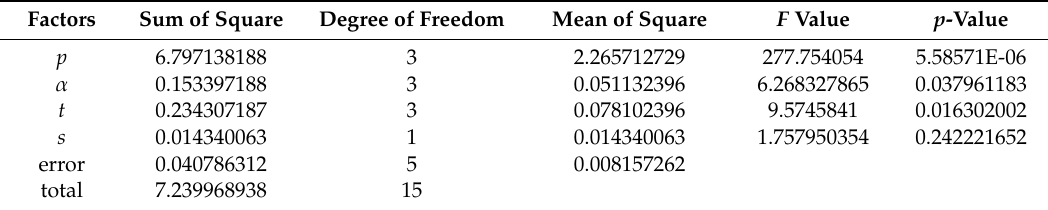
Table 5. Variance analysis table of orthogonal erosion